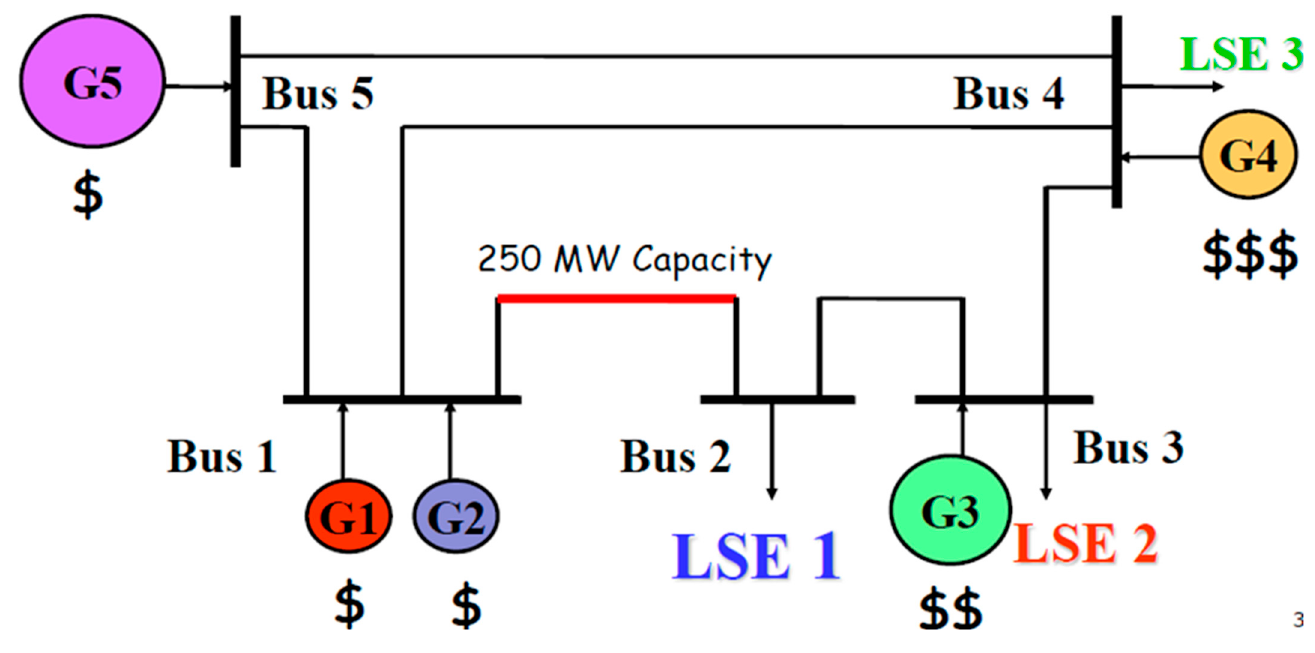
Figure 2. 5-Bus system [50]. Table 3. Line characteristics [50].